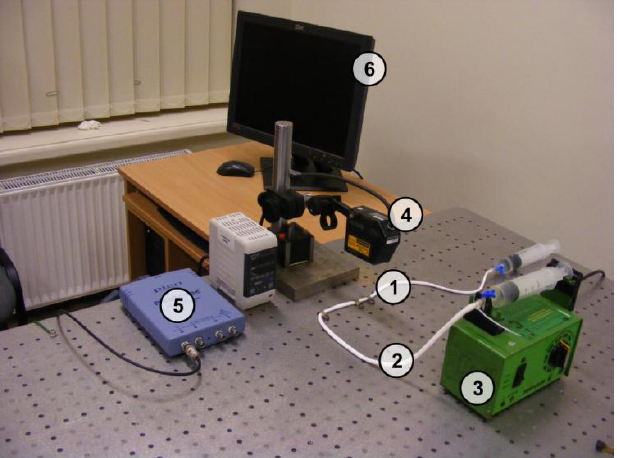
Figure 5. Experimental setup for registration of artificial radial blood flow pulsation: (1) measurement location (test point); (2) vascular graft; (3) flow speed controller; (4) laser triangulation sensor; (5) digital oscilloscope; (6) PC for data